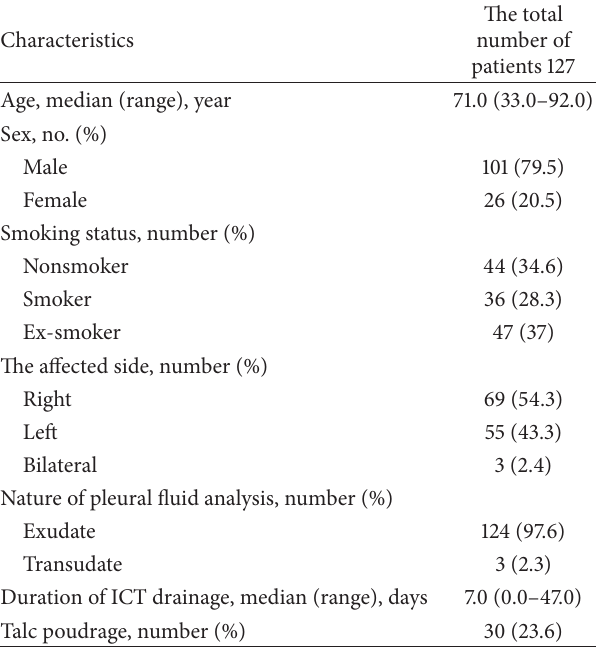
Table 1: Characteristics of patients undergoing medical thora- coscopy.